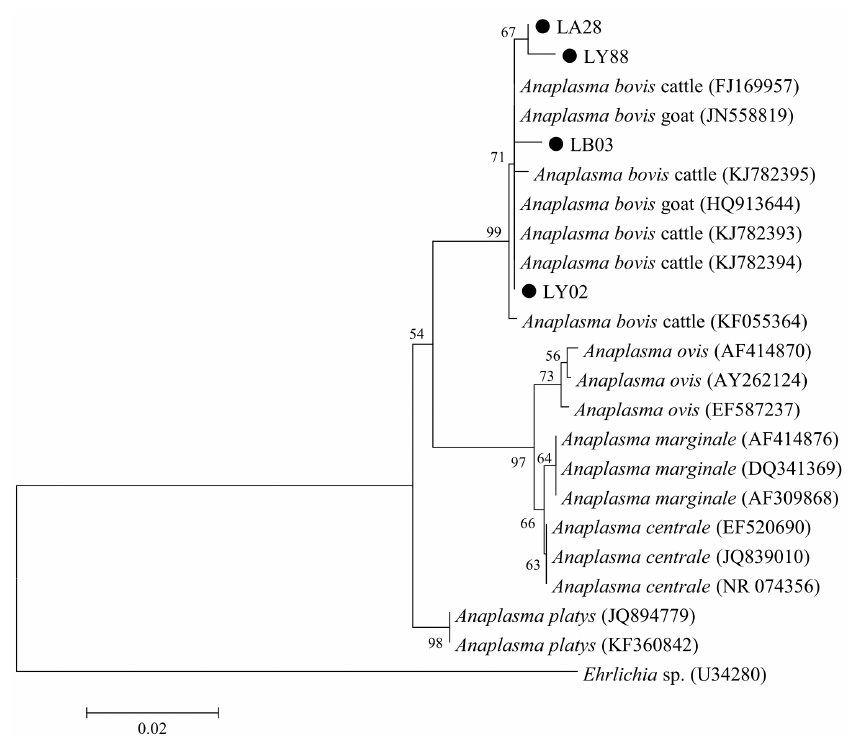
Figure 3. Phylogenetic relationships of Anaplasma bovis in the present study (black circle before the sample name) with reference sequences from GenBank™ based on the sequence analysis of the 16S rRNA gene by neighbor-joining analysis using the Kimura 2-parameter model. Bootstrap values (>50) are indicated at the nodes. Scale bar indicates 0.02 nucleotide substitutions/site. Ehrlichia sp. (U34280) is used as the outgroup.